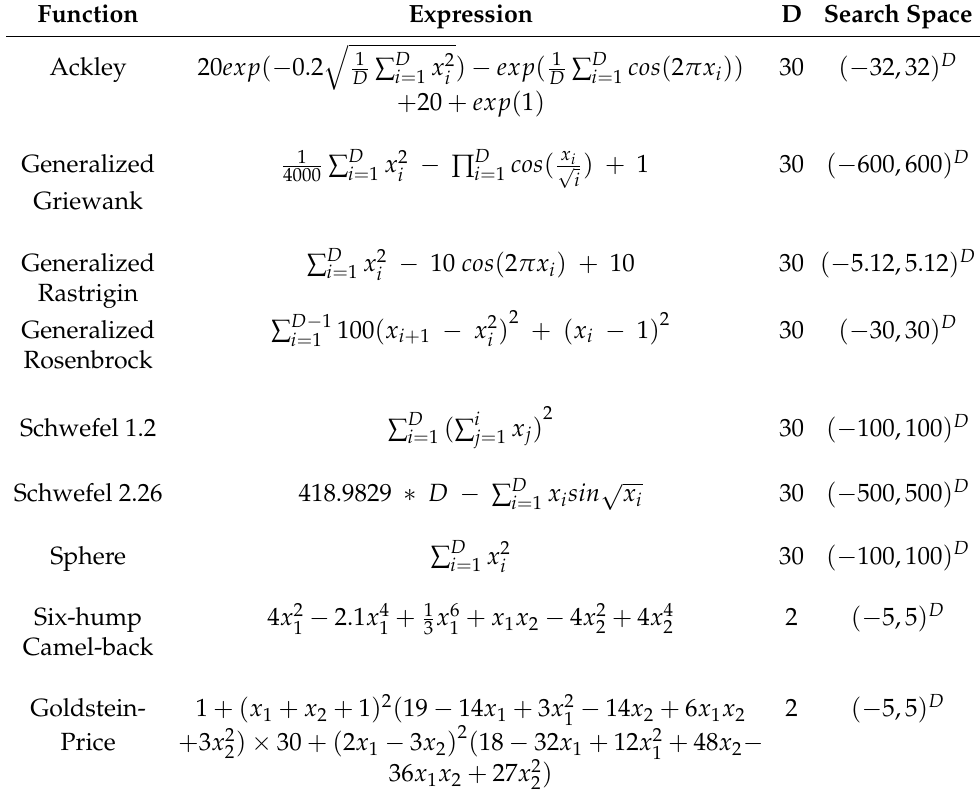
Table 1. Description of the Benchmark Functions.